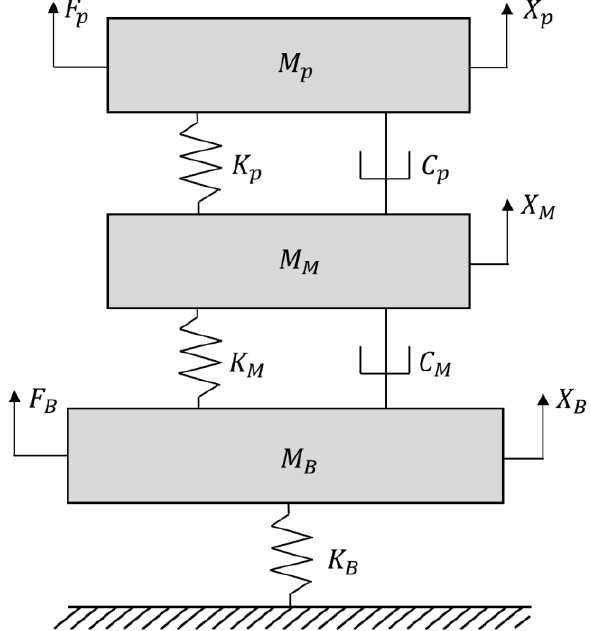
Figure 3. Equivalent electric power generator model supported by vibration